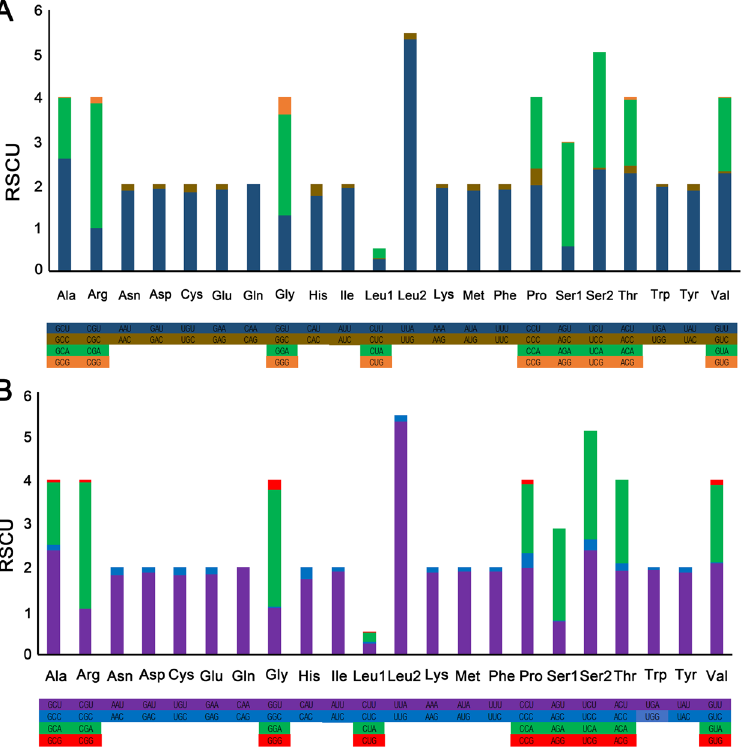
Figure 3. The relative synonymous codon usage (RSCU) in the mt genomes of A . rubiginosa ( A ) and R . menciana ( B ).